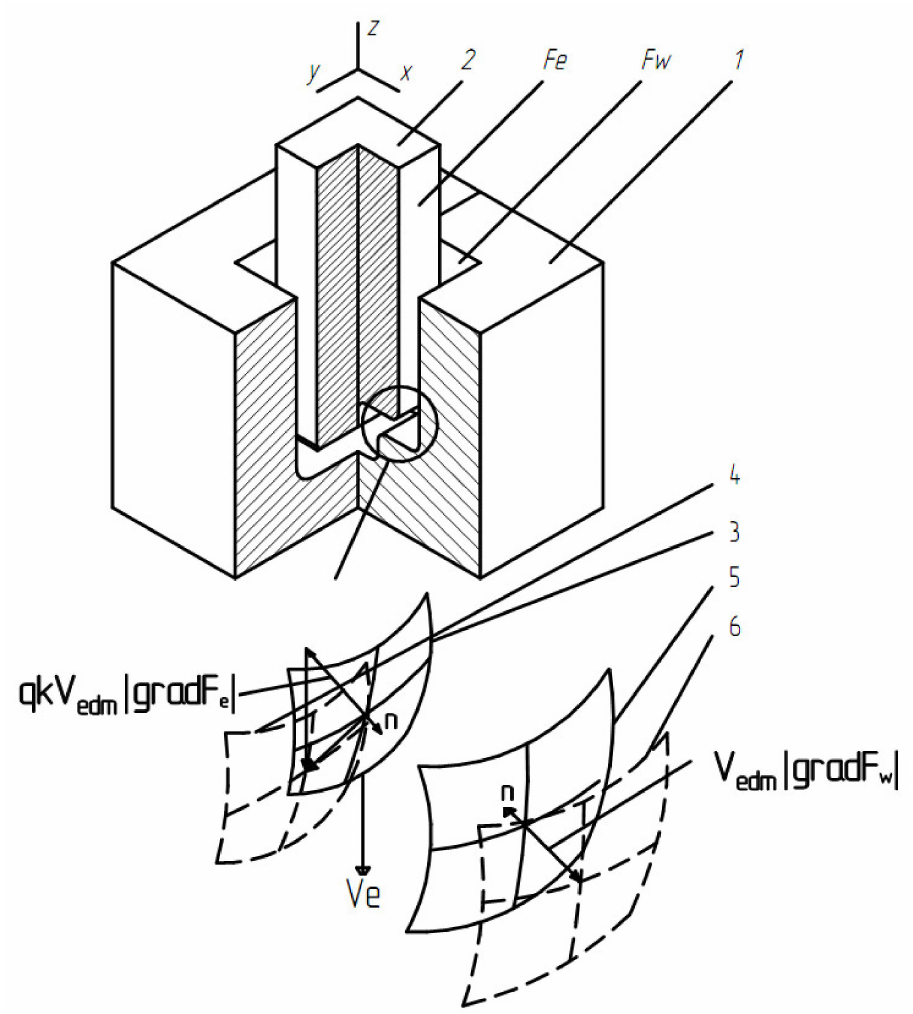
Figure 2. Changing the surfaces: 1—blank; 2—electrode tool; 3—the initial surface of the electrode; 4—a modified surface of the electrode; 5—the initial surface of the workpiece; 6—changed surface of the